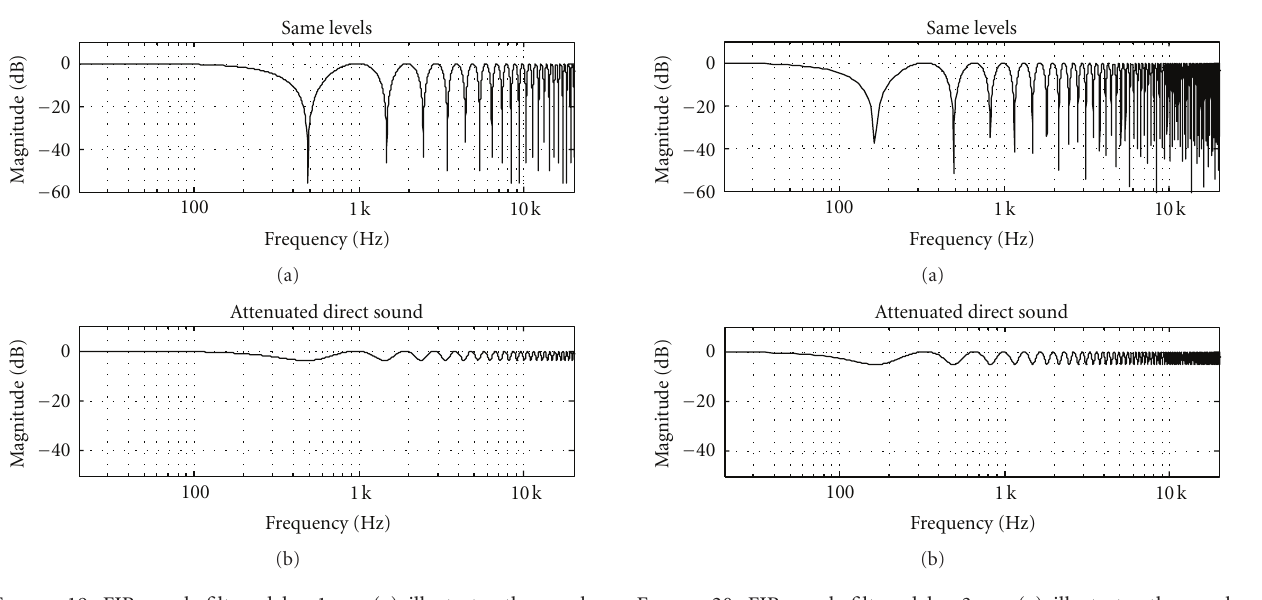
Figure 19: FIR comb filter, delay 1ms. (a) illustrates the comb filtering e ff ect, when the signals have the same energy, whereas (b) illustrates the e ff ect when the passive attenuation of the headset (at the frequency of the first notch –15 dB at 490 Hz) is taken into account.